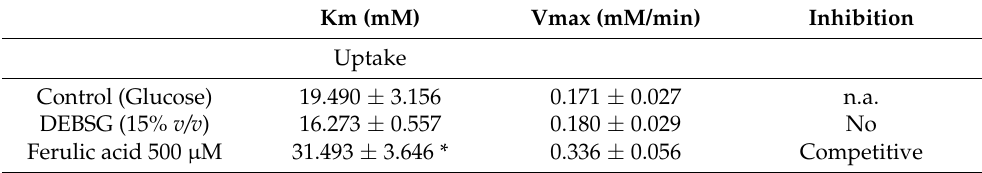
Table 10. Glucose uptake and transport kinetics in IEC-6 cells in presence of EBSG and ferulic